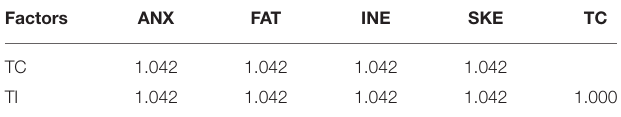
TABLE 4 | Confidence Intervals. TABLE 5 | Inner Variance Inflation Factor (VIF)